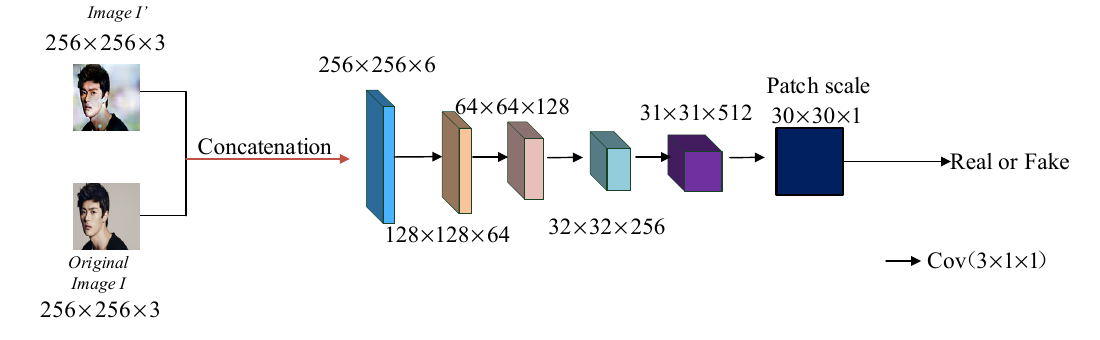
Figure 5. Proposed discriminator module.